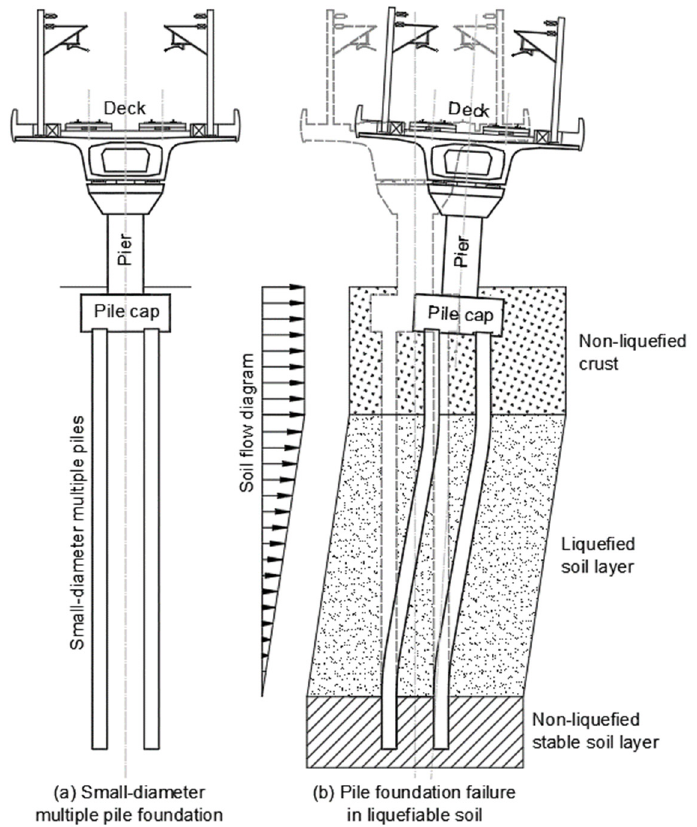
Figure 1. Lateral spreading due to liquefaction on pile foundation.